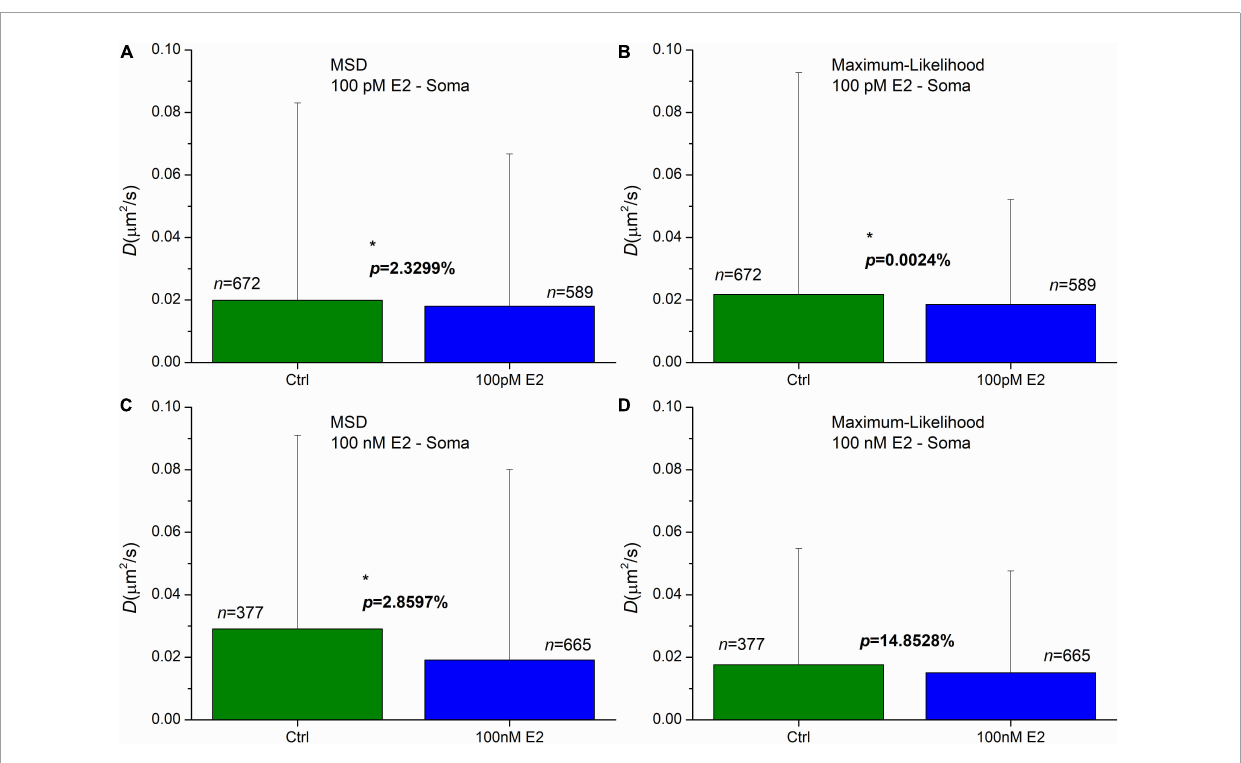
diffusion coefficient and the localization error. The first group contained immobile ( D = 0 µ m 2 / s ) trajectories in the presence of ε = 100 nm localization uncertainty. The second set contained mobile ( D = 0 . 15 µ m 2 / s ) trajectories without any localization error ( ε = 0 nm ) . The last group simulated trajectories recorded on moving particles ( D = 0 . 15 µ m 2 / s ) with ε = 100 nm measurement error. Figure 1 shows the parameters provided by the MSD and